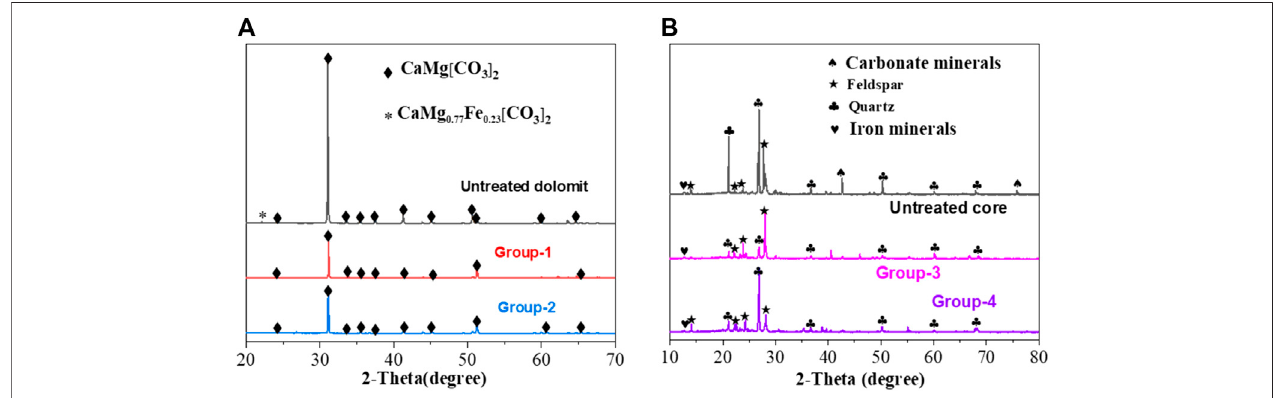
FIGURE 12 | Solid XRD analysis after dissolution: (A) comparison of untreated dolomite and Group 1 and Group 2 reactions; (B) comparison of untreated cores and Group 3 and Group 4 reactions.